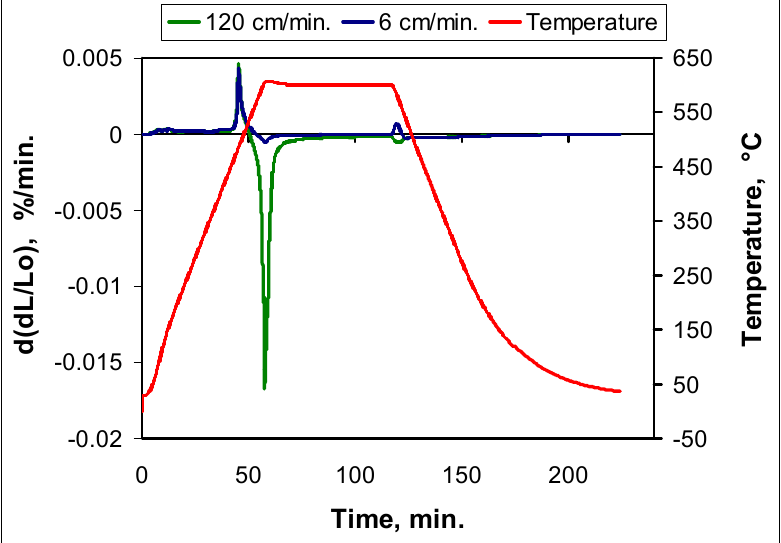
Figure 6. Dimensional change rate curves for sintering of Alumix 431D compacts containing 1.5 mass% of Acrawax C for different nitrogen linear flows.